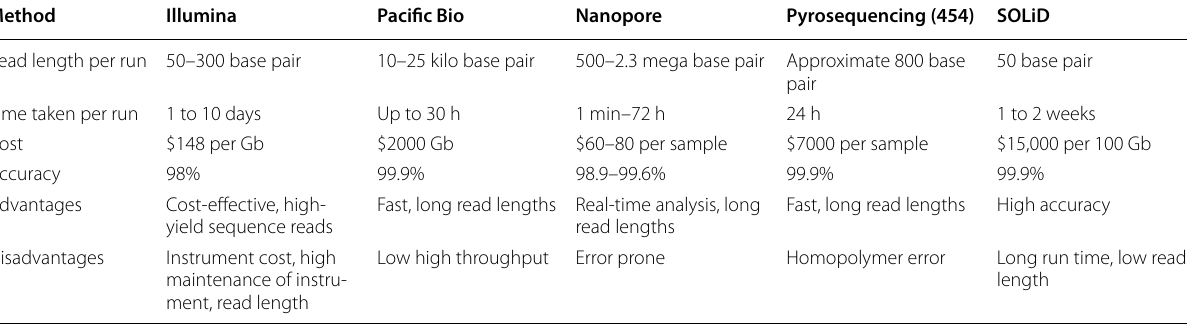
Table 2 Comparison between next-generation sequencing